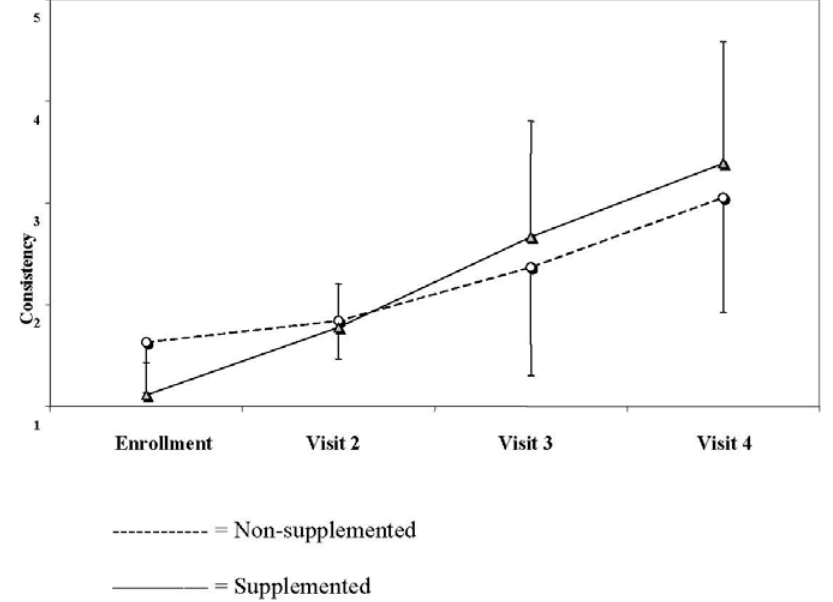
Figure 2. Stool consistency in the two groups over the study period (based on parents' scores from 1 = watery stools to 5 = hard